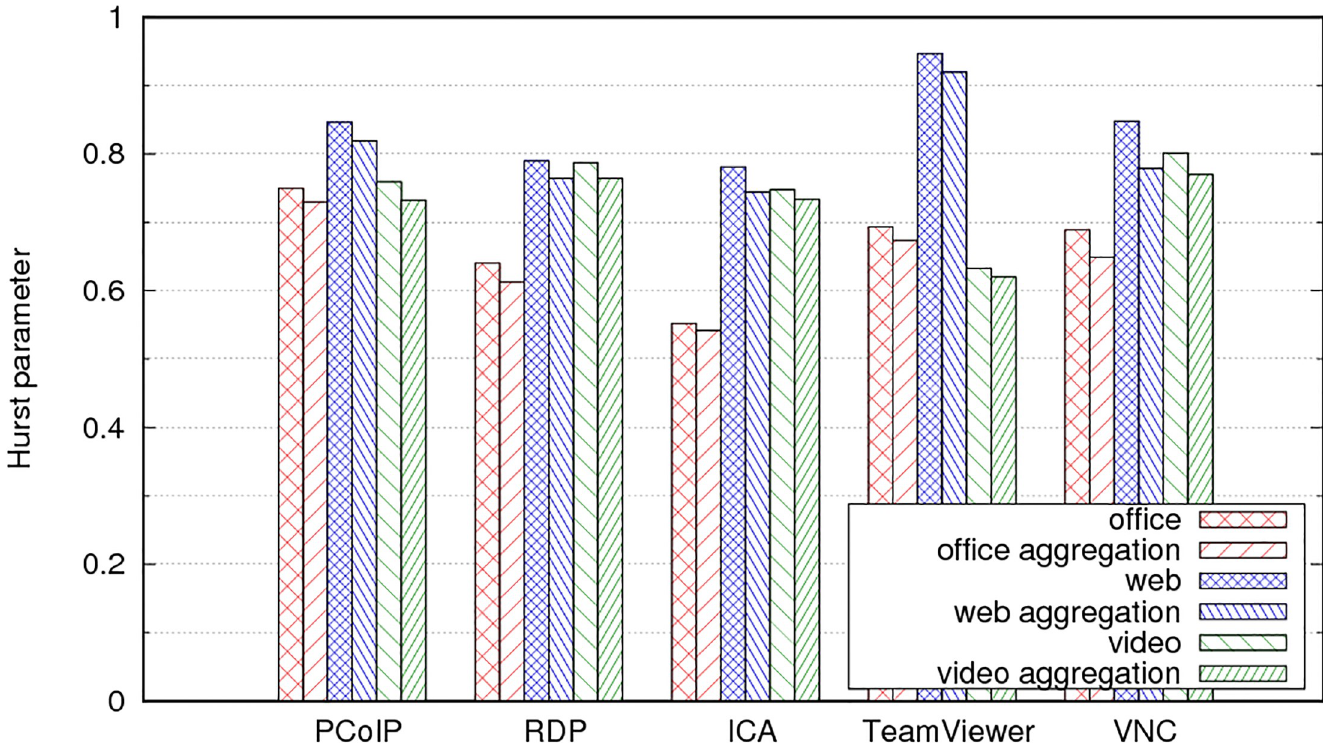
Fig 14. Values of H comparing one user and multiplex of 90 users.